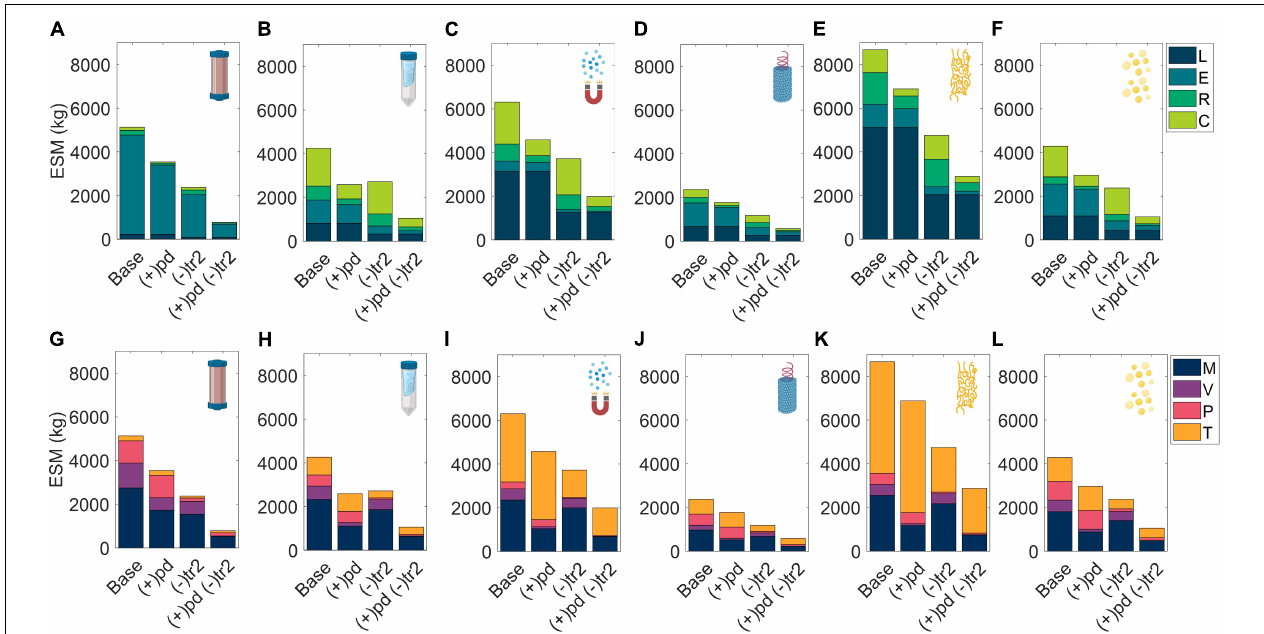
FIGURE 8 | Evaluation of extended equivalent system mass values in various mission configurations broken down by labor (L), equipment (E), raw materials (R), and consumables (C) cost categories cost category and mass (M), volume (V), power (P), and labor time (T) constituents for CHM, (A,G) , SPN, (B,H) , MAG, (C,I) , VIN, (D,J) , ELP (E,K) , and OLE, (F,L) . Configurations include the base case scenario of manufacturing resources flown with the crew for pharmaceutical production on the surface and return transit (Base), and alternatives in which the manufacturing resources are flown prior to the crew in pre-deployment, (+)pd, the production window is limited to surface operations, (–)tr 2 , and a combination of the two previously stated alternatives, (+)pd (–)tr 2 . CHM, pre-packed chromatography; SPN, spin column; MAG, magnetic bead; VIN, plant virus-based nanoparticle; ELP, elastin-like polypeptide; OLE, oilbody-oleosin.